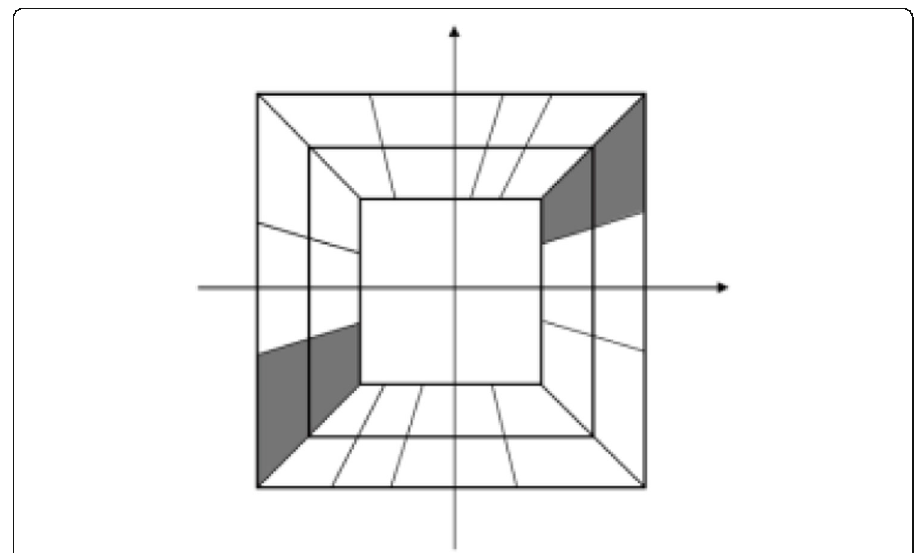
Fig. 3 two dimensional shear wave decomposition